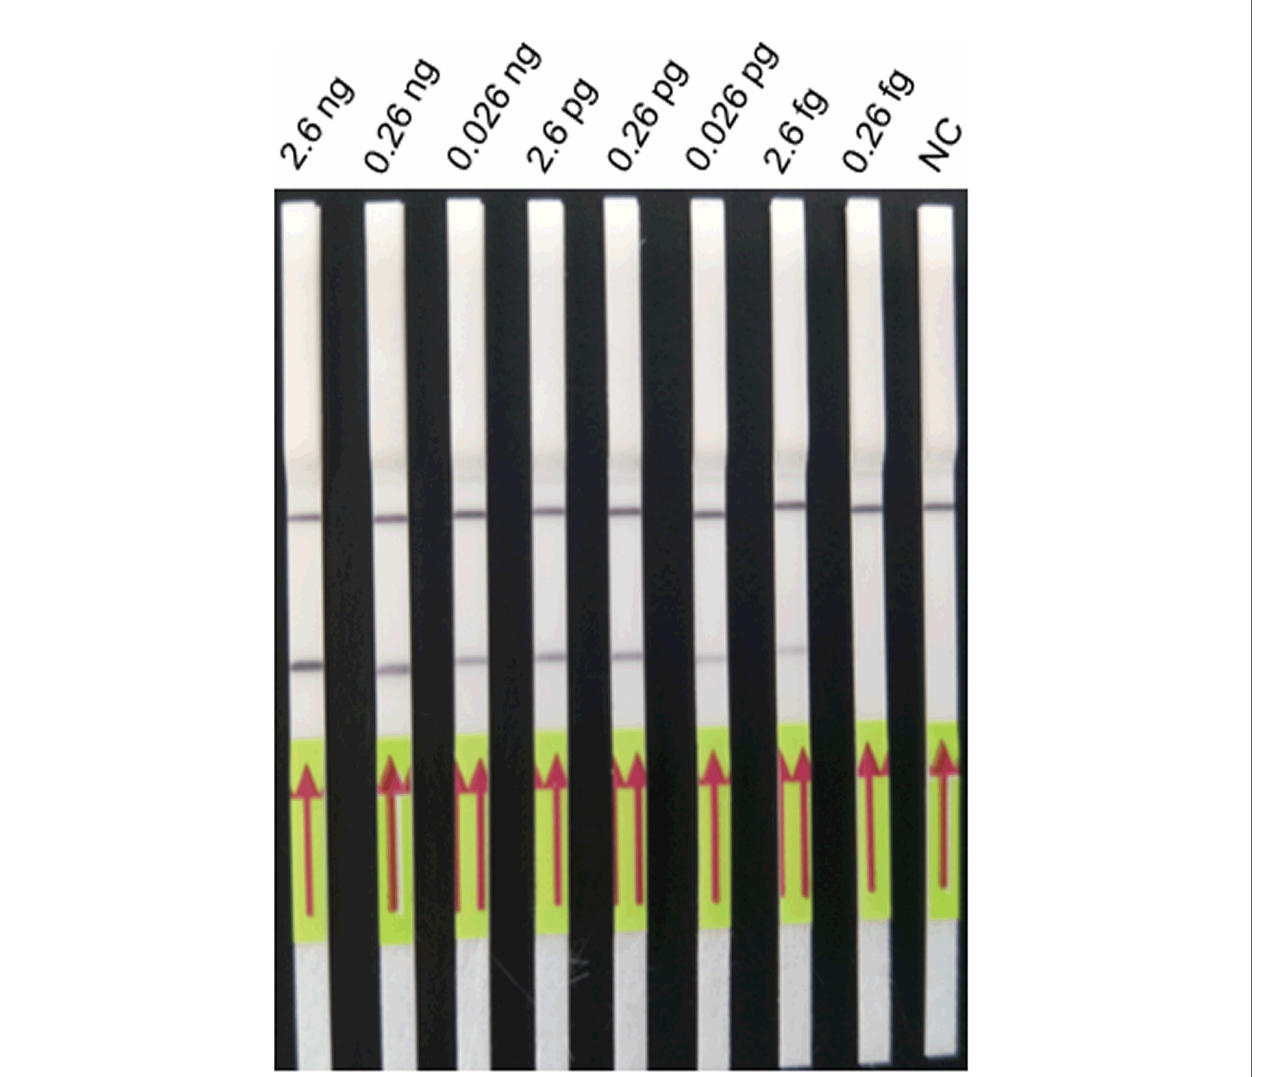
FIGURE 5 | The lower limit of detection of the LFD-RPA assay. Positive plasmid containing the S. japonicum target sequence at concentrations from 2.6 nanogram (ng)/ m l to 0.26 fg/ m l was used to determine the minimum detection concentration in the LFD-RPA assay. The minimum detection concentration is 2.6 fg/ m l. Negative control (NC), DNA extracted from negative samples. The red arrows stand for the direction of reaction solution diffusing in the lateral fl ow